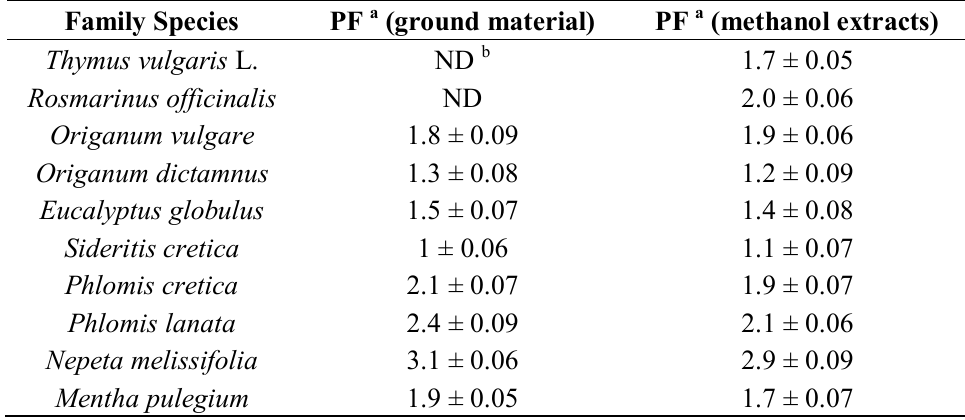
Table 5. Antioxidant capacity of plant extracts in PF